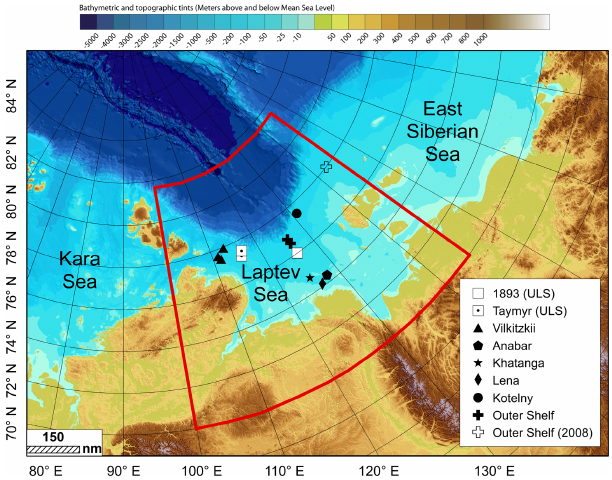
Figure 1. Map of the Laptev Sea showing the validation data (VAL) mooring sites. ESA CCI-2 SIT data from the enclosed area (red) were used for the calculation of satellite SIT anomaly (Fig. 2). IB- CAO base map provided by Jakobsson et al.